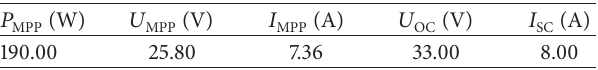
Table 1: Electrical performanceof the NP190GKg PV module under STC.